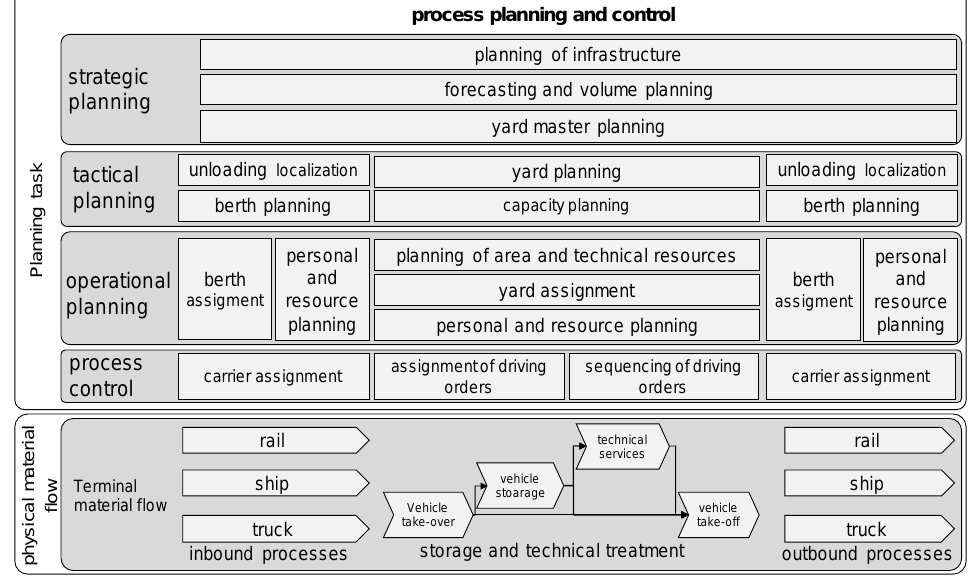
Figure 1. Material flow processes and related terminal planning tasks—based on [13].